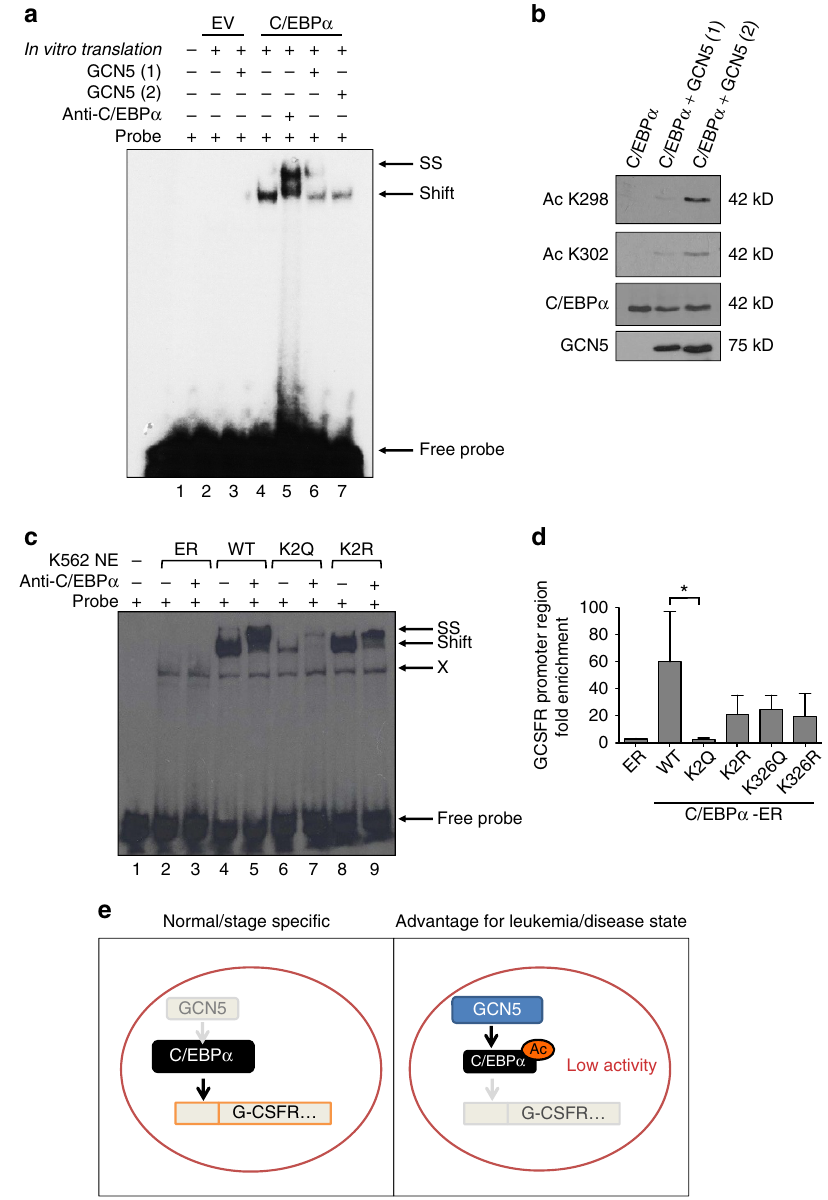
Figure 5 | Acetylation in the basic region impairs DNA binding ability. ( a ) GCN5 attenuates DNA binding ability of C/EBP a in vitro . EMSA was performed using a double-stranded C/EBP a binding site oligonucleotide. In vitro -translated C/EBP a was incubated with two separate sources of recombinant GCN5 (HAT) domain proteins. Co-incubation of ivt C/EBP a with GCN5 (lane 6, 7) resulted in decrease in DNA binding as compared to C/EBP a